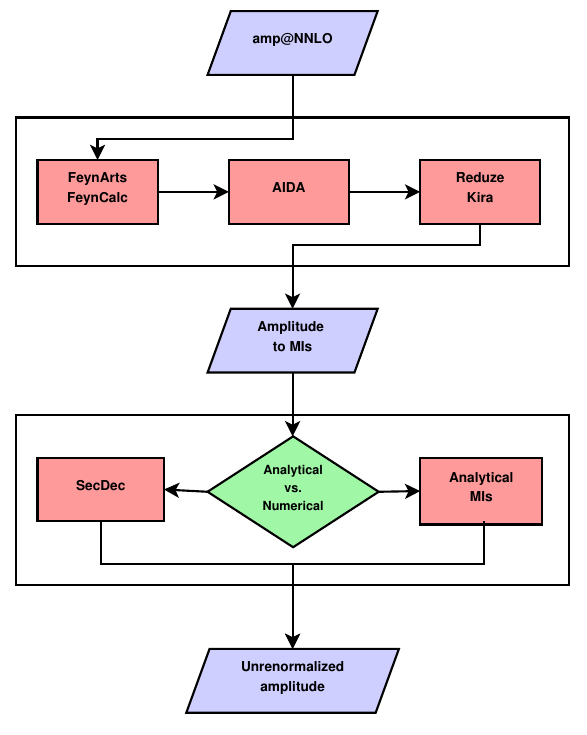
Figure 2. Flowchart of the algorithm